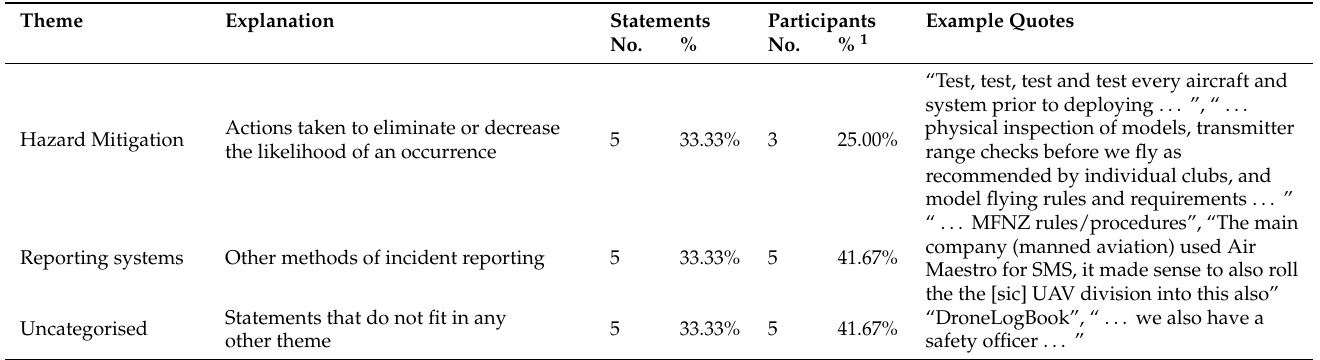
Table 9. Alternative systems used by participants to monitor safety